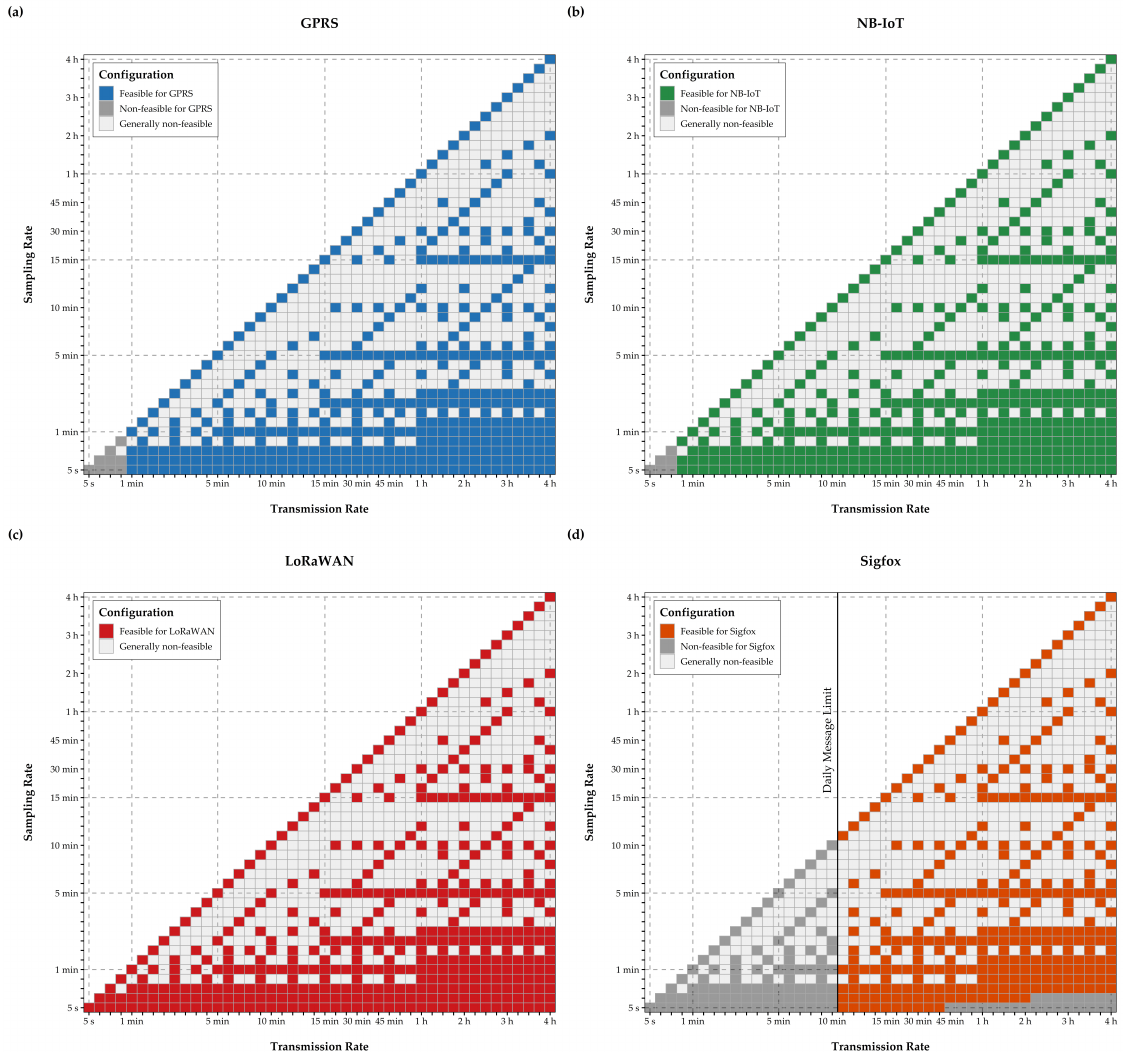
Figure 6. Feasible configurations for each communication technology ( a – d